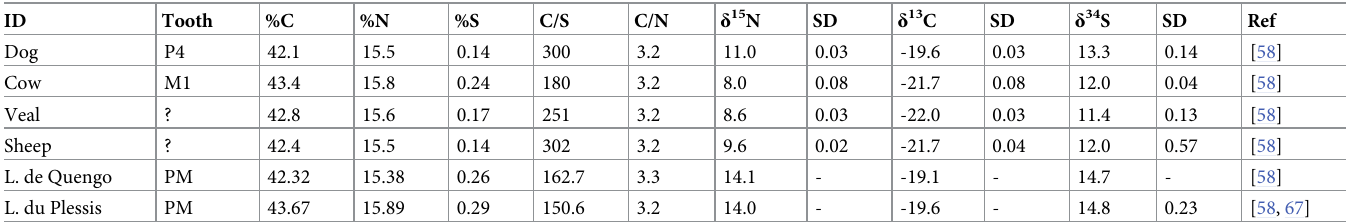
Most data were collected in this study, except for a few individuals for which the reference is provided. C/S, N/S and C/N ratios are provided to underline the good preservation of the collagen from these samples. Delta values are expressed in ‰.